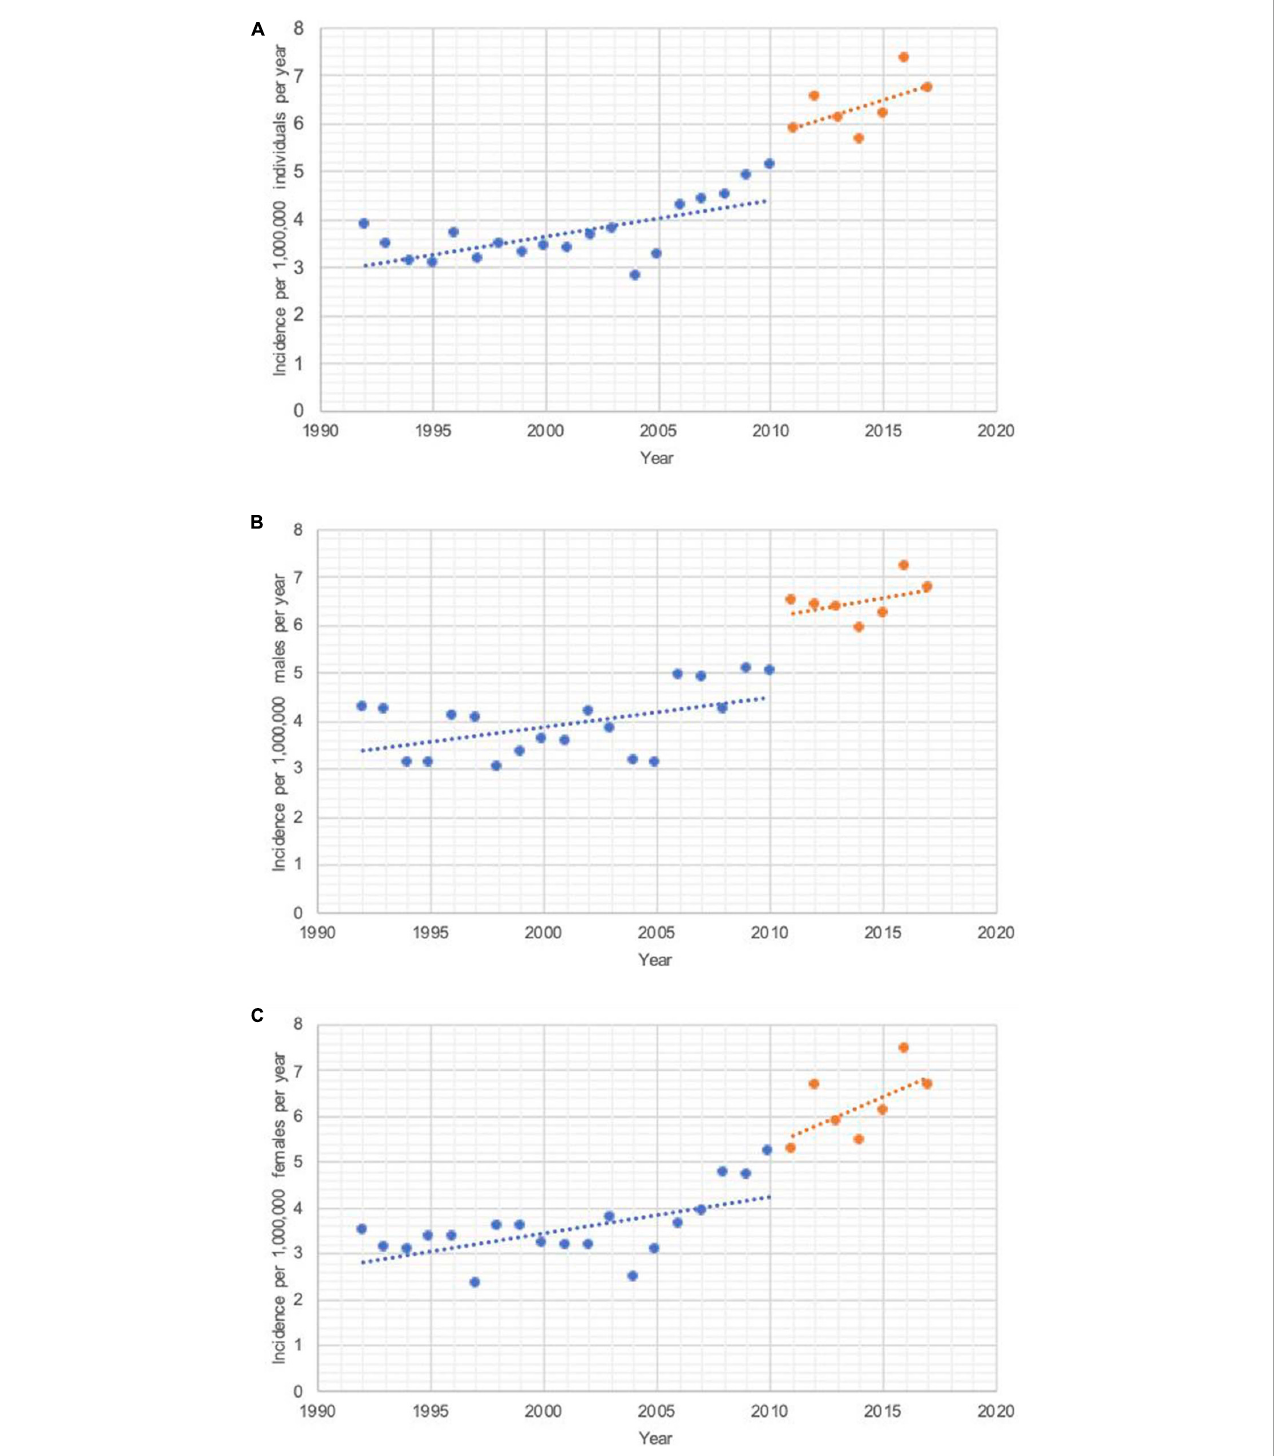
FIGURE1 Incidence rates (cases per million individuals per year) during 2011–2017 vs. 1992–2010 years. (A) All uveal melanoma cases. A total of 2011–2017: ( R 2 ) = 0.32; p = 0.19 and the slope of the line was 0.15 ± 0.097 cases per million individuals per year. The average incidence rate of uveal melanoma in Canada was 6.36 cases per million individuals per year. A total of 1992–2010: ( R 2 ) = 0.42; p = 0.003 and the slope of the line was 0.074 ± 0.021 cases per million individuals per year. The average incidence rate of uveal melanoma in Canada was 3.75 cases per million individuals per year. (B) Uveal melanoma in males. A total of 2011–2017: ( R 2 ) = 0.17; p = 0.35 and the slope of the line was 0.081 ± 0.079 cases per million males per year. The average incidence rate of uveal melanoma in males in Canada was 6.50 cases per million individuals per year. A total of 1992–2010: ( R 2 ) = 0.30; p = 0.016 and the slope of the line was 0.069 ± 0.026 cases per million males per year. The average incidence rate of uveal melanoma in males in Canada was 3.93 cases per million individuals per year. (C) Uveal melanoma in females. A total of 2011–2017: ( R 2 ) = 0.36; p = 0.16 and the slope of the line was 0.21 ± 0.13 cases per million females per year. The average incidence rate of uveal melanoma in females in Canada was 6.22 cases per million individuals per year. A total of 1992–2010: ( R 2 ) = 0.36; p = 0.007 and the slope of the line was 0.079 ± 0.025 cases per million females per year. The average incidence rate of uveal melanoma in females in Canada was 3.54 cases per million individuals per